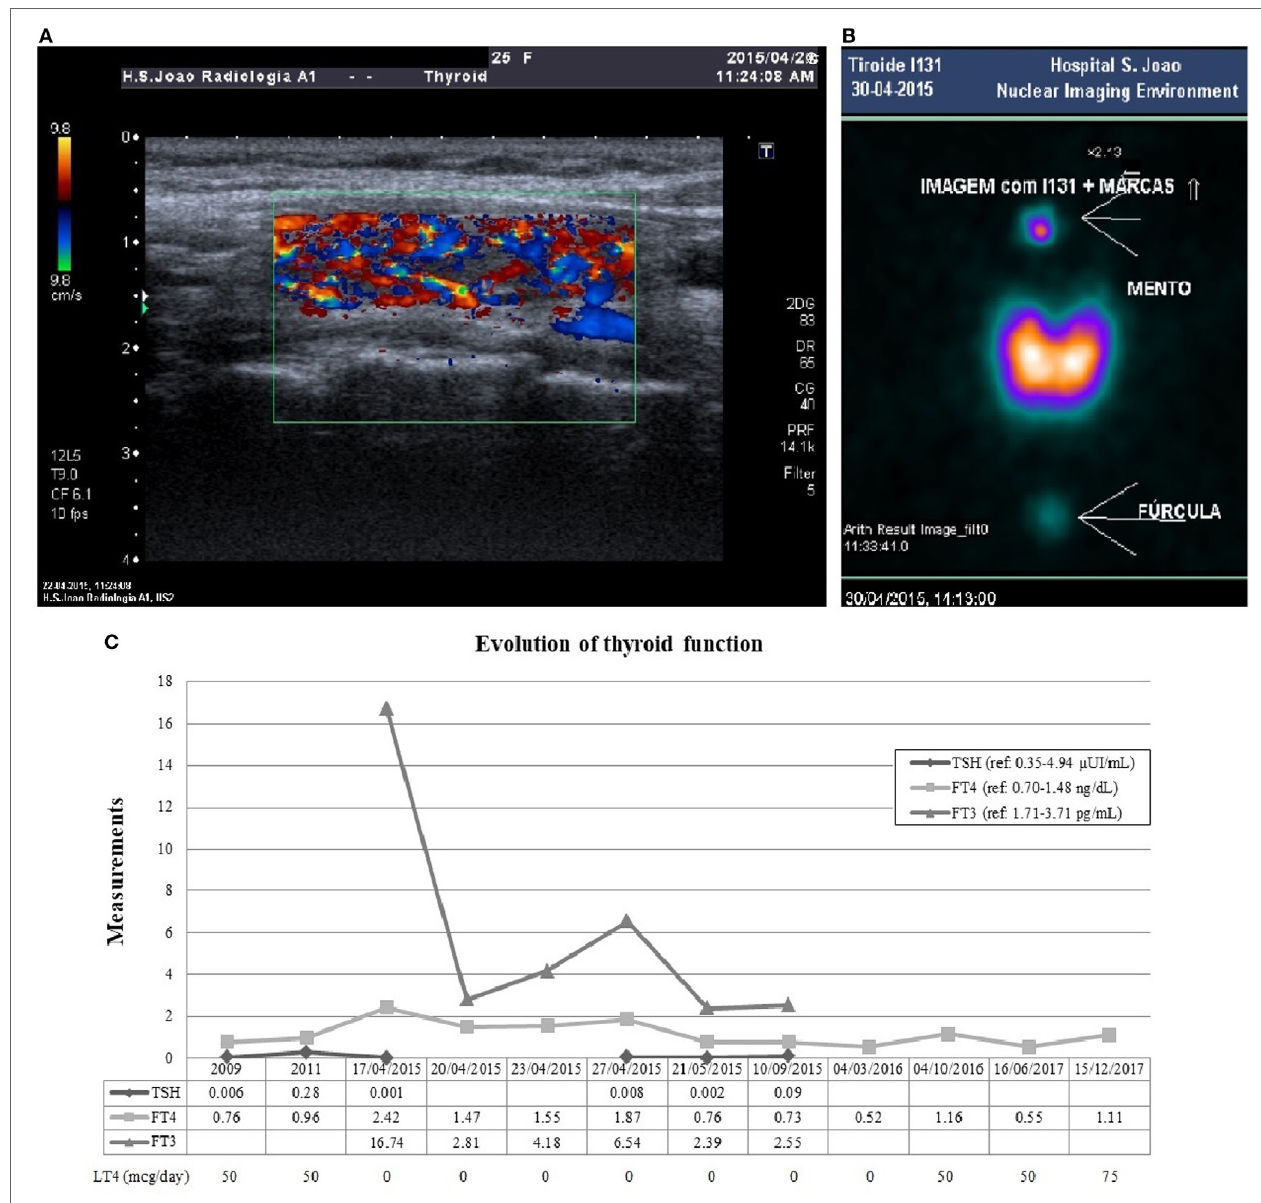
FIGURe 3 | Thyroid ultrasonography (a) showed a normal size gland, with heterogeneous texture and pseudonodular areas, without nodular lesions, suggesting thyroiditis. The color flow Doppler signal showed significantly increased vascularity with diffuse homogeneous distribution (thyroid inferno ). There was a markedly hyperfunctioning thyroid in scintigraphy (B) , with homogeneous activity distribution and no focal areas suggestive of hyper- or hypoactive nodular formations. The radioactive iodine uptake was 70.2% at the end of 24 h, markedly elevated compared to normal range (10–30%). Panel (C) shows the evolution of thyroid function. After pituitary surgery in 2009 the patient developed secondary hypothyroidism and initiated LT4. She was admitted with primary hyperthyroidism in April 2015 and initiated MMI. During antithyroid drug withdrawal before scintigraphy, FT4 and FT3 re-increased above the reference range. MMI was progressively reduced after 6 months of treatment, but after withdrawal in October 2015, central hypothyroidism recurred and she resumed LT4 since March 2016. Abbreviations: LT4, levothyroxine; MMI, methimazole; FT4, free thyroxine; FT3, free